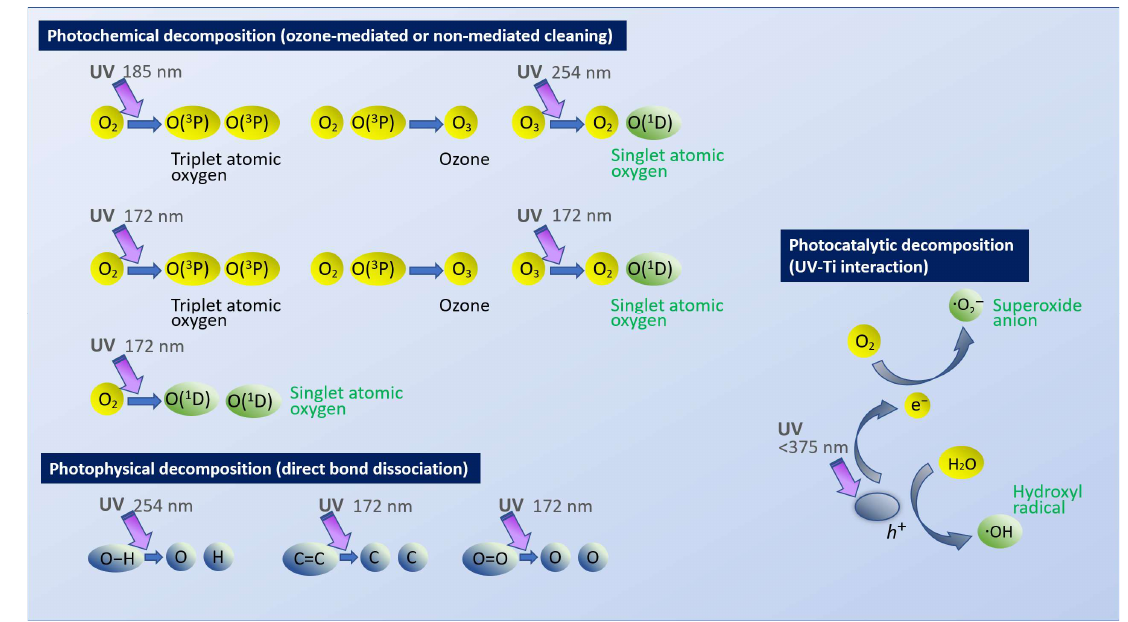
Figure 9. Schematic of three different mechanisms of UV-mediated organic decomposition. During photochemical and photocatalytic decomposition, the generated reactive oxygens (highlighted in green) attack organic molecules. Note that 172 nm VUV light has both photochemical and photo- physical advantages, enabling faster and more efficient